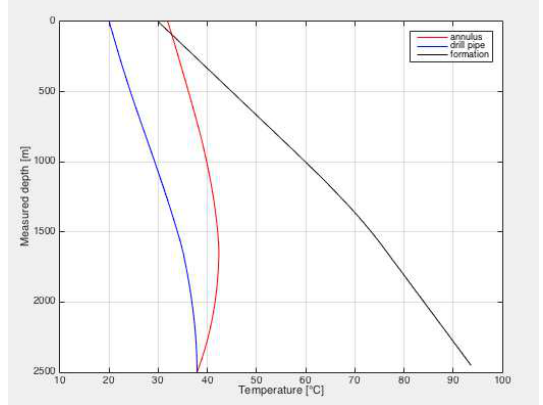
Figure 1: Temperature distribution-base